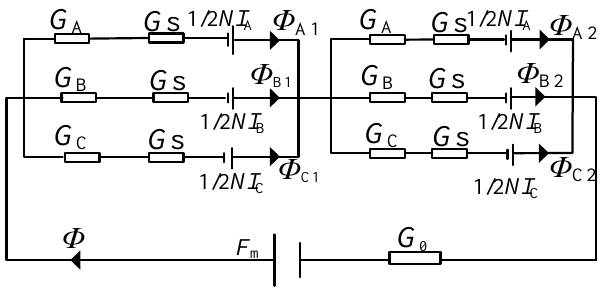
Figure 5. Magnetic circuit considering edge effect.